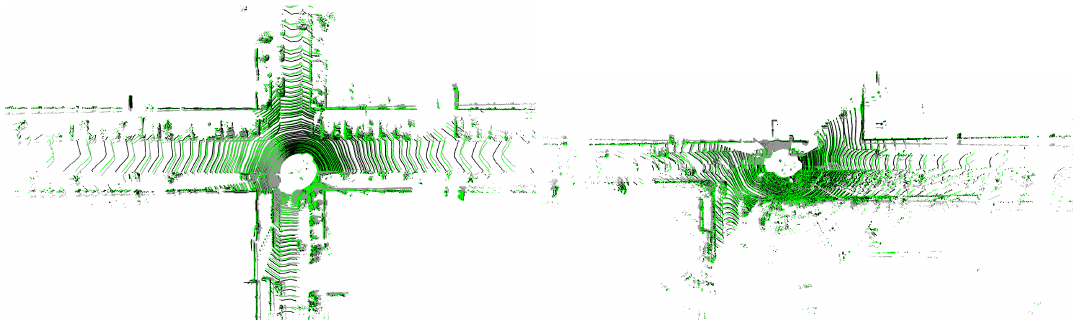
Figure 3. Two different examples of registered point clouds seen from a bird’s-eye view, originating from the KITTI ‘00’ sequence. The black and gray scans have been selected by the M2DP algorithm as the start and the end point of a potential loop. The two point clouds are, however, slightly rotated. Our registration technique aligns both (the green point cloud is the transformed version of the gray one) and determines their overlap. When the overlap is sufficiently high, the loop candidate is eventually selected as a true loop. Here, one can see that the green and black point cloud are sufficiently